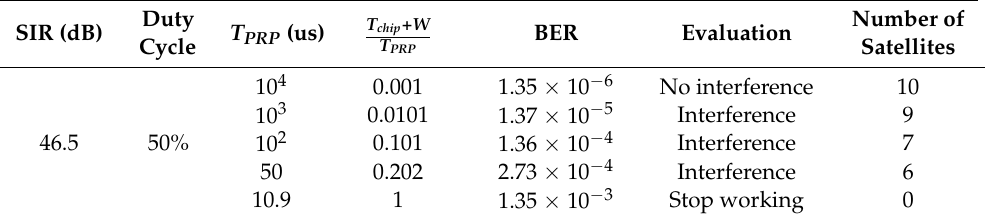
Table 2. EMC evaluation experiment results of BDS when changing repetition period.